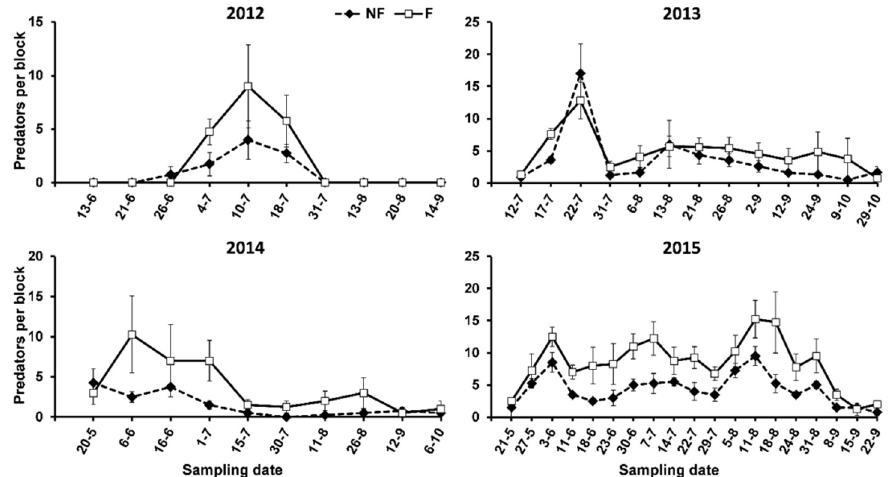
Figure 5. Abundance of total predators on oleanders surrounded (F) and not surrounded (NF) by service plants in the study period.